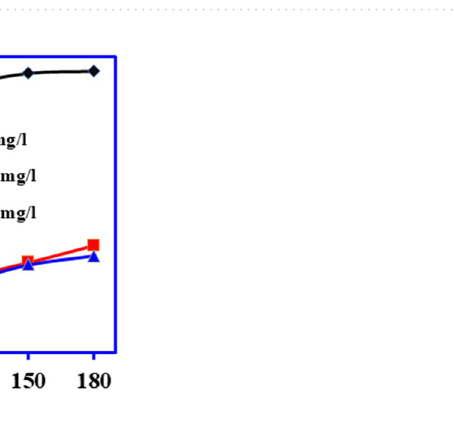
Figure 7. Role of initial DCF concentration onto photocatalysis using BiOCl-GO composite under solar light irradiation. (pH 6, vol.—100 mL, time 0–180 min, catalyst dose = 1.0 g L −1 )